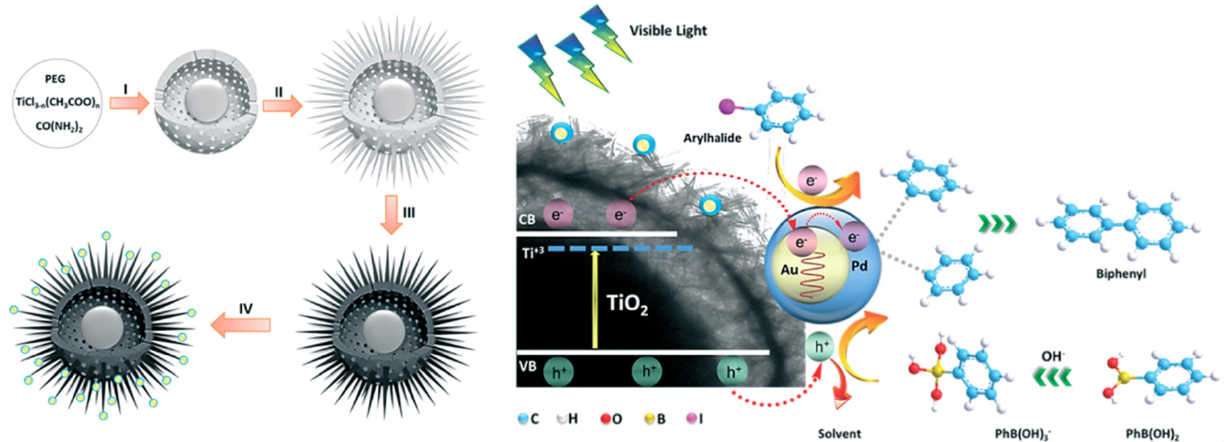
Figure 10. The HUY@S-TOH/AuPd for visible-light-driven photocatalytic Suzuki coupling. Reproduced with permission from Reference [112]. Copyright 2019 Royal Society of Chemistry.